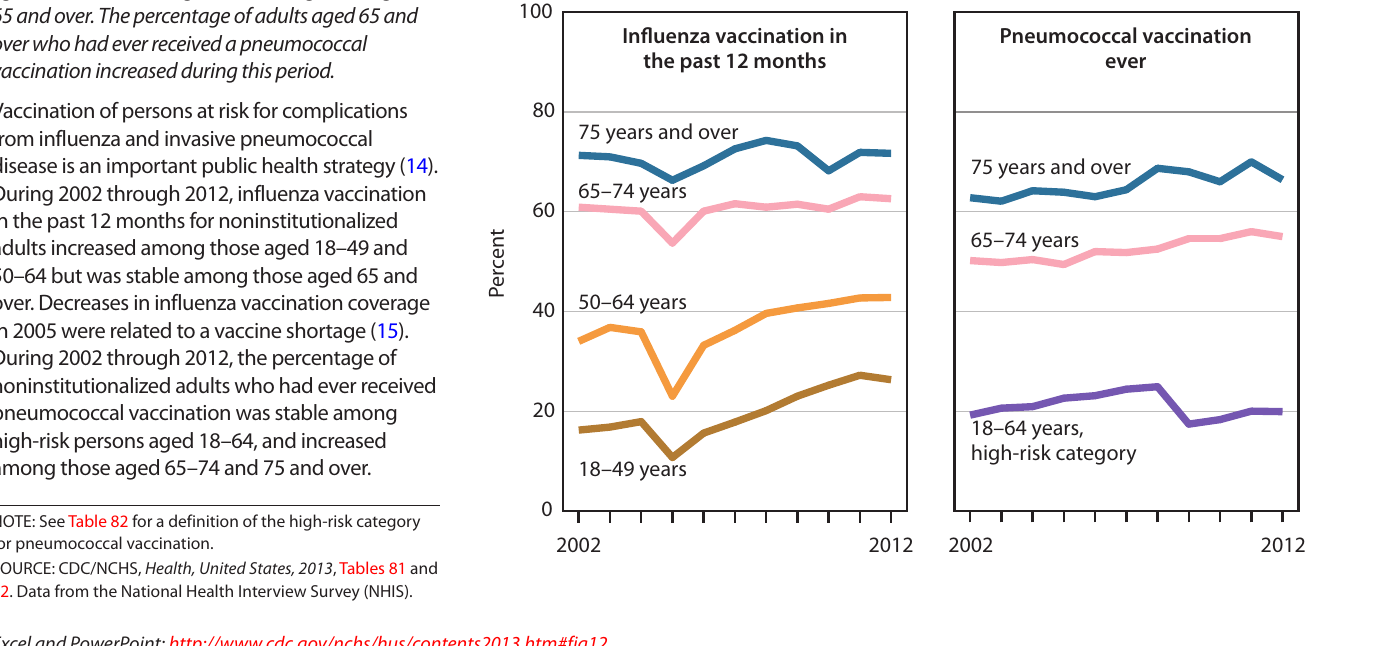
Figure 12. Influenza and pneumococcal vaccination among noninstitutionalized the past 12 months increased among adults